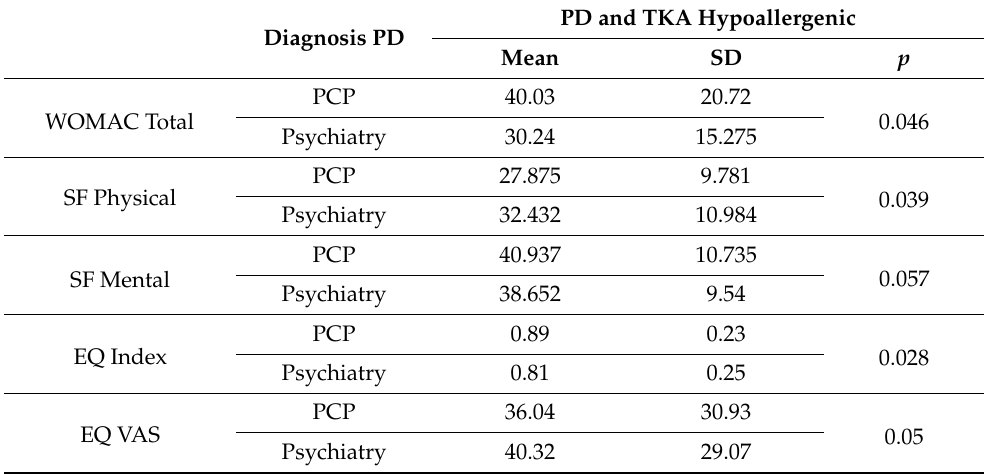
Table 5. Student’s t results for independent samples of preoperative hypoallergenic psychological distress and TKA and diagnosis of distress by PCP or psychiatry with respect to the results of the questionnaires (WOMAC, SF-12 and Euro-Qol-5D). Diagnosis PD